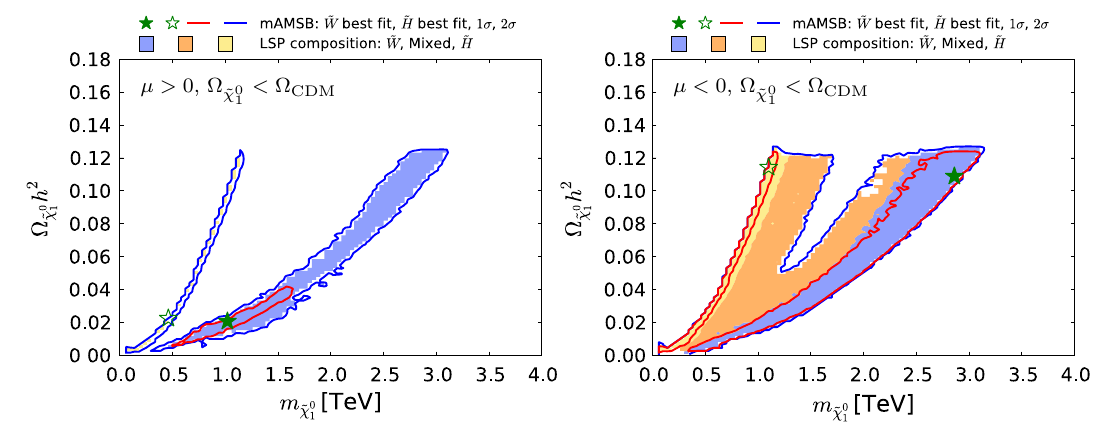
Fig. 14 The ( M A , tan β) planes for μ > 0 ( left panel ) and for μ < 0 ( right panel ), allowing the ˜ χ 0 The shadings are the same as in Fig. 4